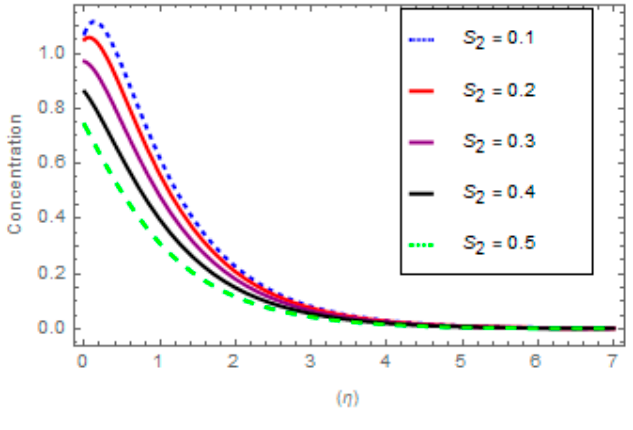
Figure 19. Result of S 2 via ϕ ( η ) .